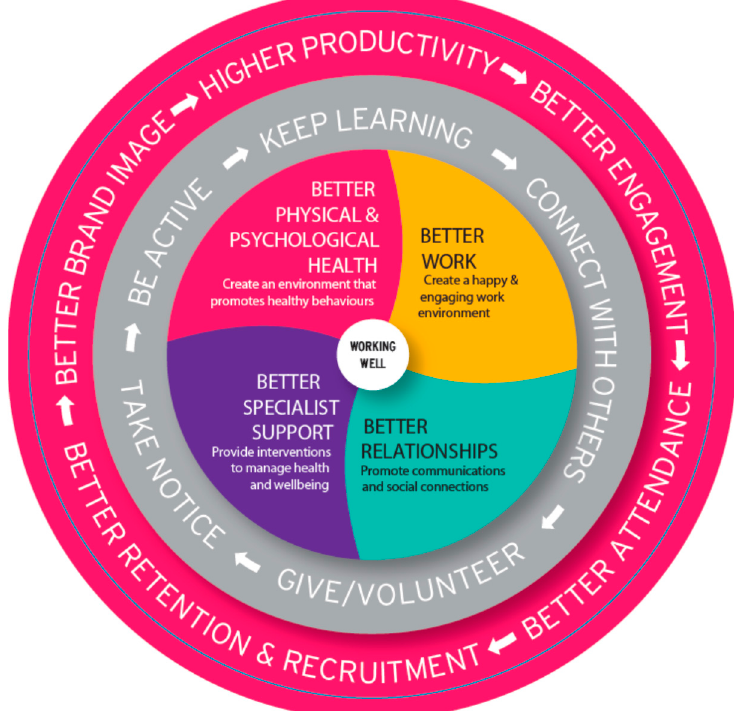
Figure 1. Business in the community “Workwell Model”.